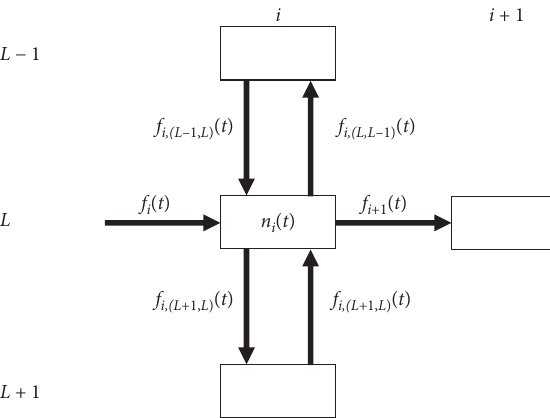
Figure 4: Schematic diagram of flows within a cell.